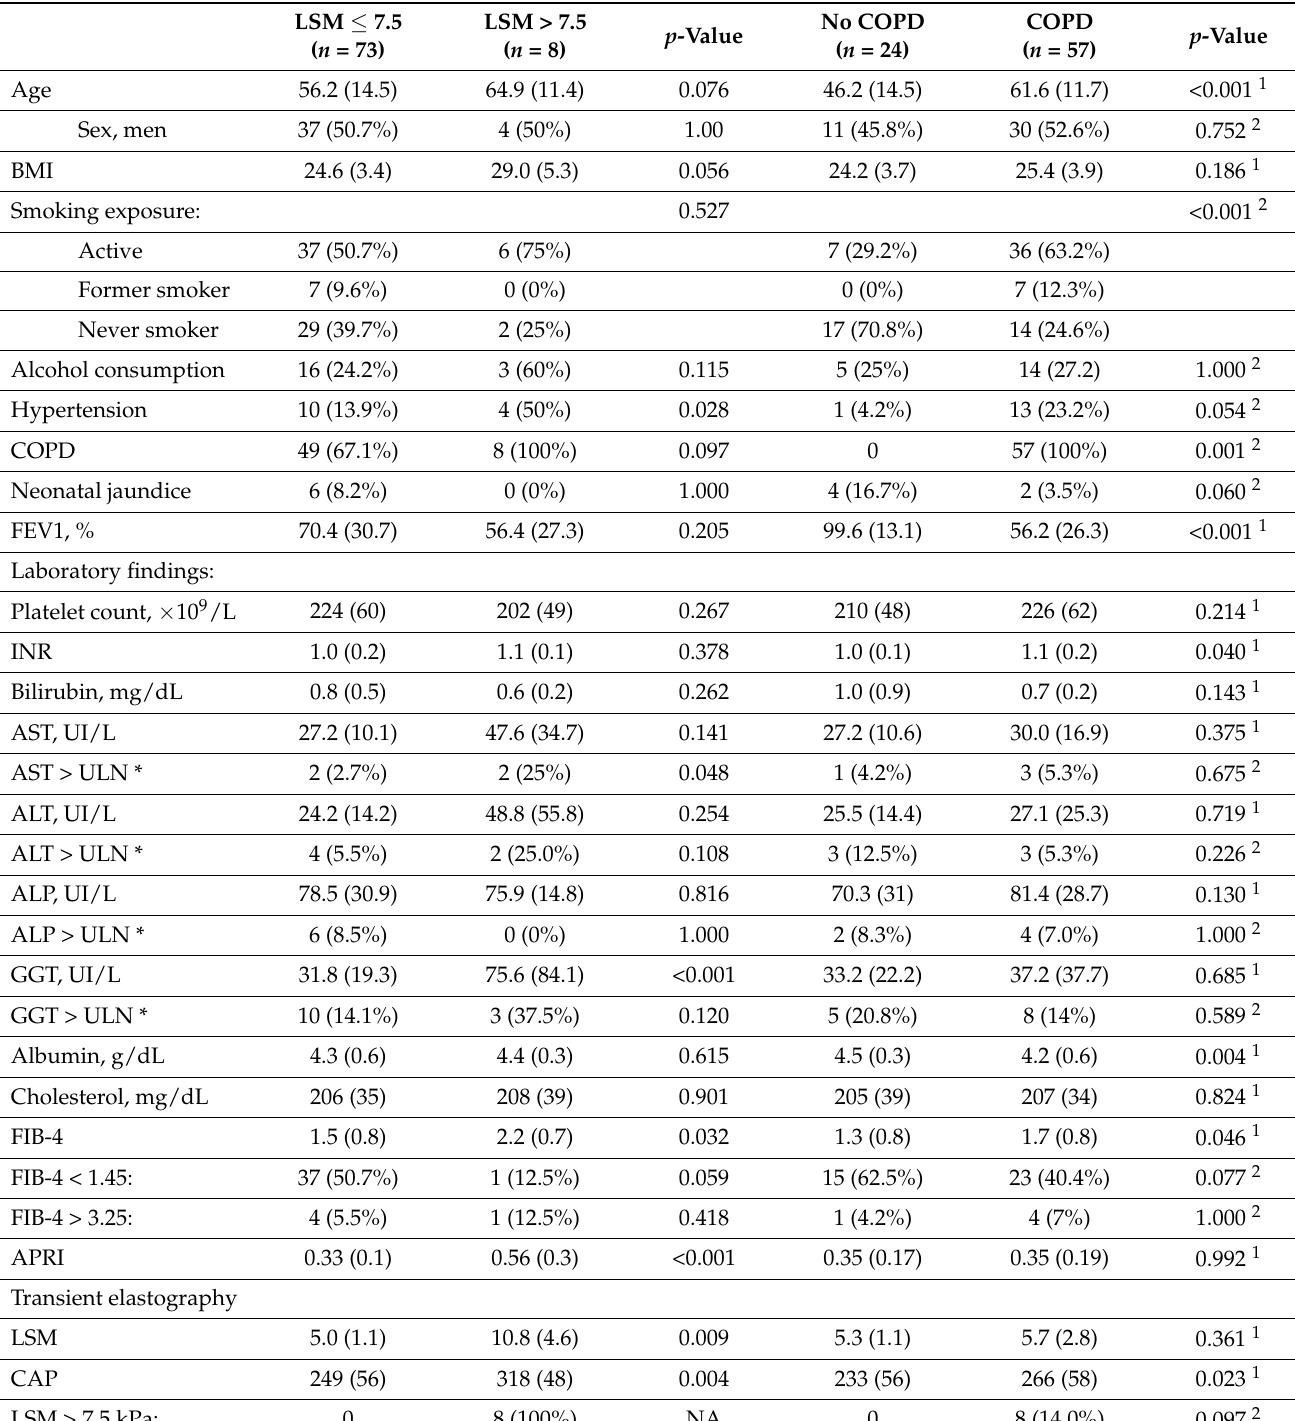
Table 3. Comparison between Pi*ZZ individuals based on liver stiffness (LSM) and diagnosis of chronic obstructive pulmonary disease